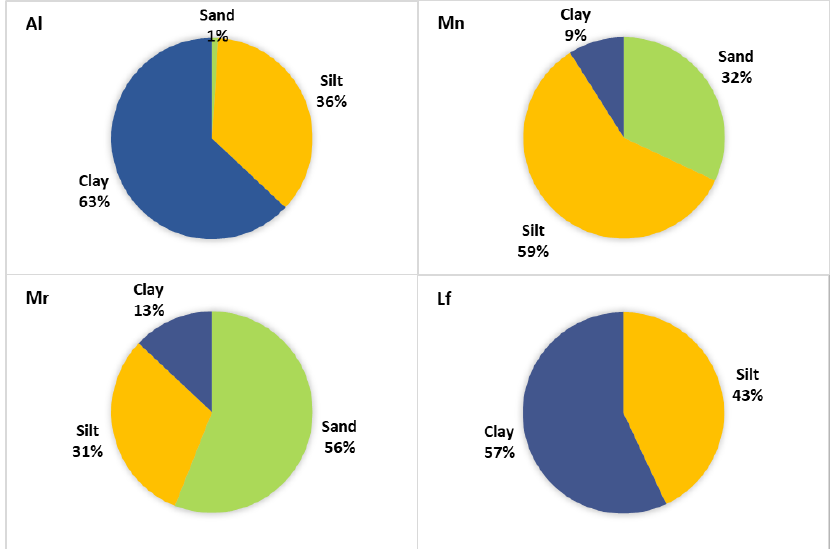
Figure 9. Sediments’ granulometric fractions at each sampling location (Al: Á lamos; Mn: Montante; Mr: Mourão; Lf: Lucefécit) in the Alqueva reservoir.